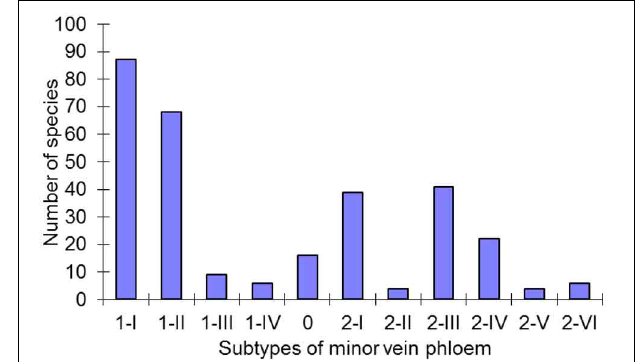
FIGURE 6 | Distribution of the subtypes of minor vein phloem among 320 species in the Asteridae. For every subtype defined, the number of species assigned to this subtype is